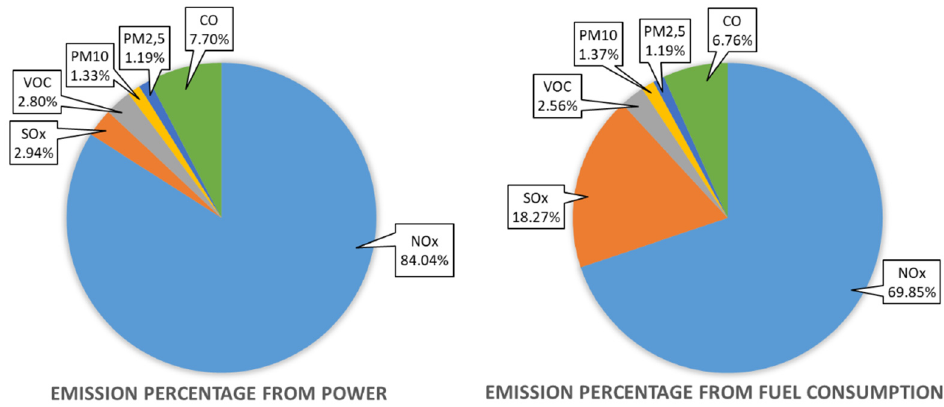
Figure 5. Common polluting emissions percentages of the Ro–Ro ships in the Port of Vigo.